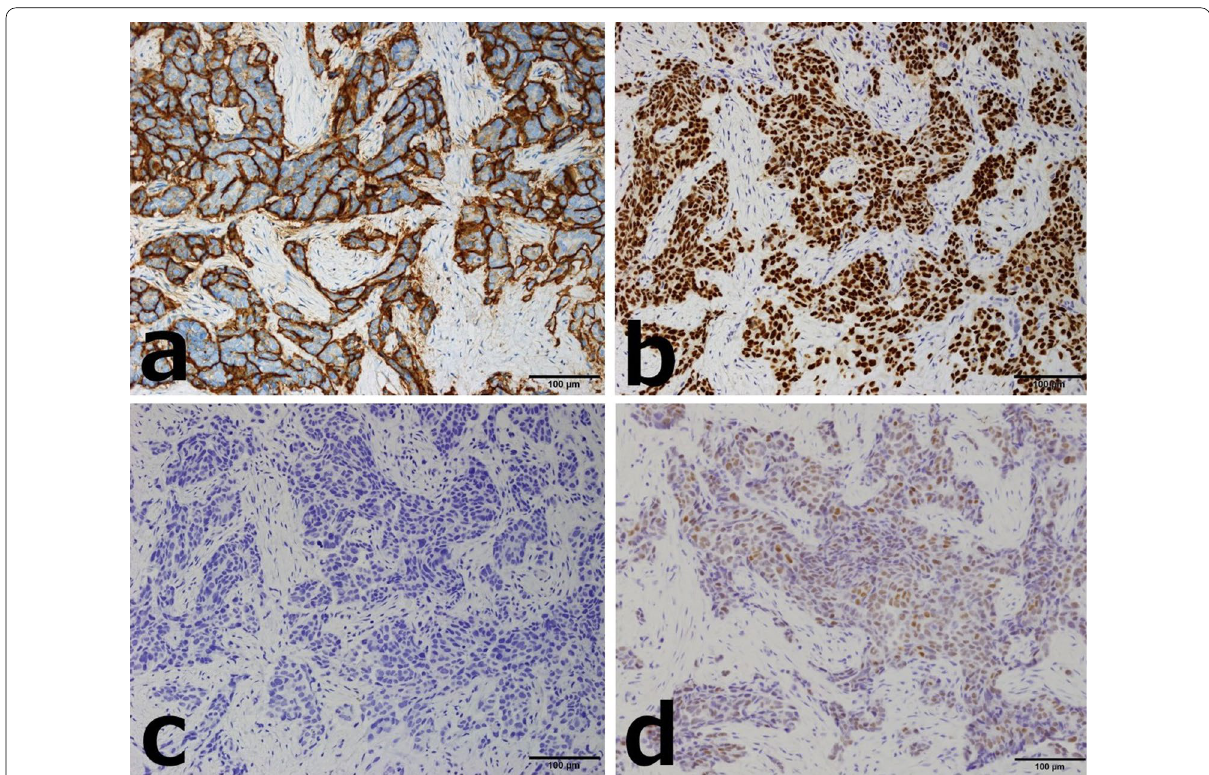
Fig. 3 Case 1: breast tumor histopathology (immunostaining). a CA125. b WT-1. c GCDFP15. d PAX-8. Immunostaining revealed diffuse positivity for CA125, WT-1, and PAX-8, and negativity for GCDFP15, suggesting a high-grade serous carcinoma derived from the uterus, ovary, fallopian tube, or peritoneum